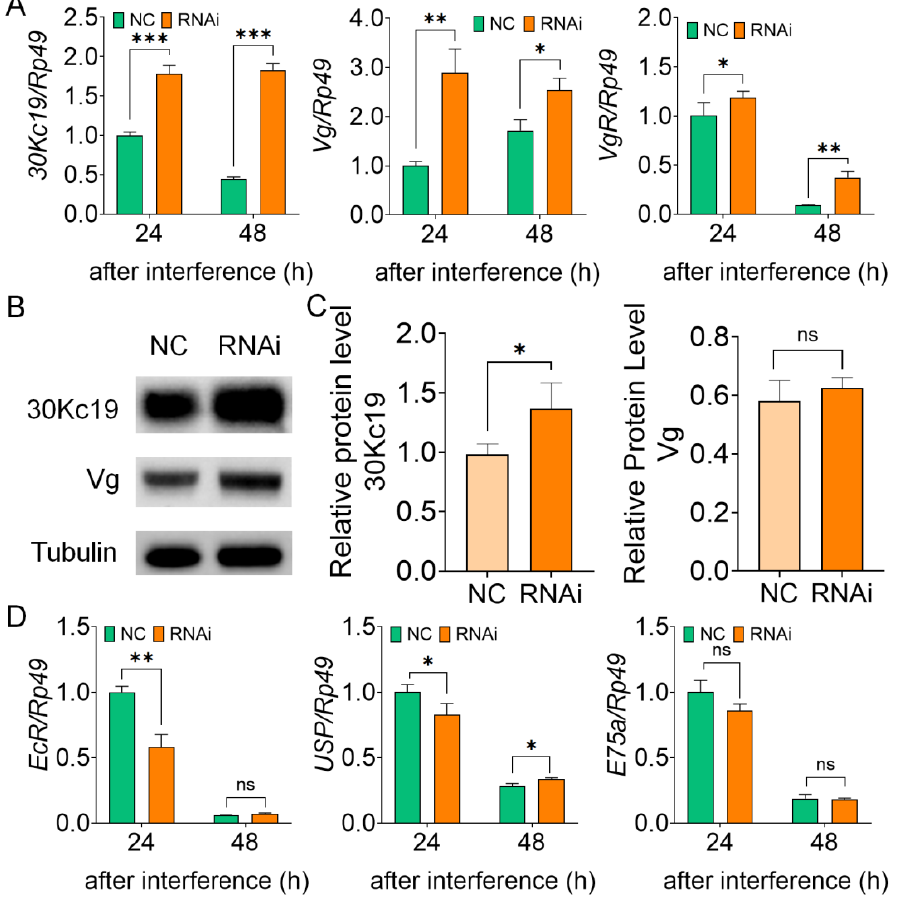
Figure 3. Effects of BmFhl2 knockdown on the expression of egg protein and the 20E receptor gene. ( A ) qPCR results of the expression levels of 30Kc19 , Vg , and VgR in fat body at 24 and 48 h after interference. ( B ) WB results of the expression levels of 30Kc19 and Vg in fat body at 48 h after interference. ( C ) Quantitative analysis of WB results. ( D ) qPCR results of the expression of EcR , USP , and E75a in fat body at 24 and 48 h after interference. *, p ≤ 0.05; **, p ≤ 0.01; ***, p ≤ 0.001; ns: nonsignificant difference. Rp49 was used as the qPCR reference gene, while tubulin was used as the WB reference protein. Mean ± SD, N = 3. All samples were collected and mixed for three silkworm populations.